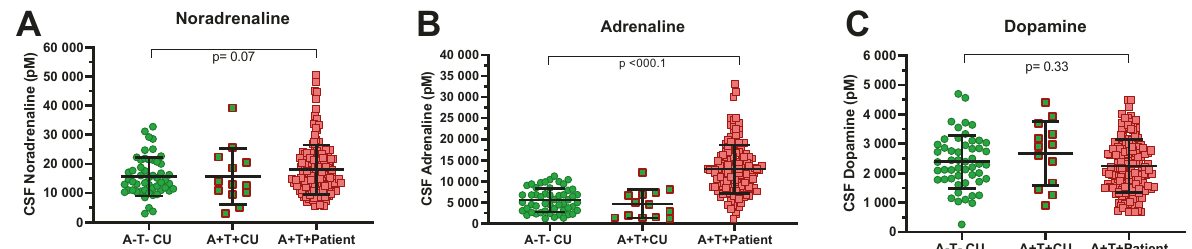
Fig. 2 CSF catecholamines in AT re fi ned groups. A A + T + patients did not have statistically signi fi cant higher CSF noradrenaline compared to the A − T − cognitively unimpaired (CU). However B The CSF adrenaline concentration was higher in A + T + patients compared to A − T − CU. In contrast C CSF dopamine concentrations were similar between A + T + patients and A − T − CU. A – C There were no differences in neither CSF noradrenaline, adrenaline nor dopamine between A + T + and A − T − CU suggesting no alterations prior to symptomatic AD (all p > 0.05). The larger and smaller lines represent mean and standard deviation respectively while p-values are obtained by t -test. AD Alzheimer ’ s disease, CSF cerebrospinal fl uid, CU cognitively